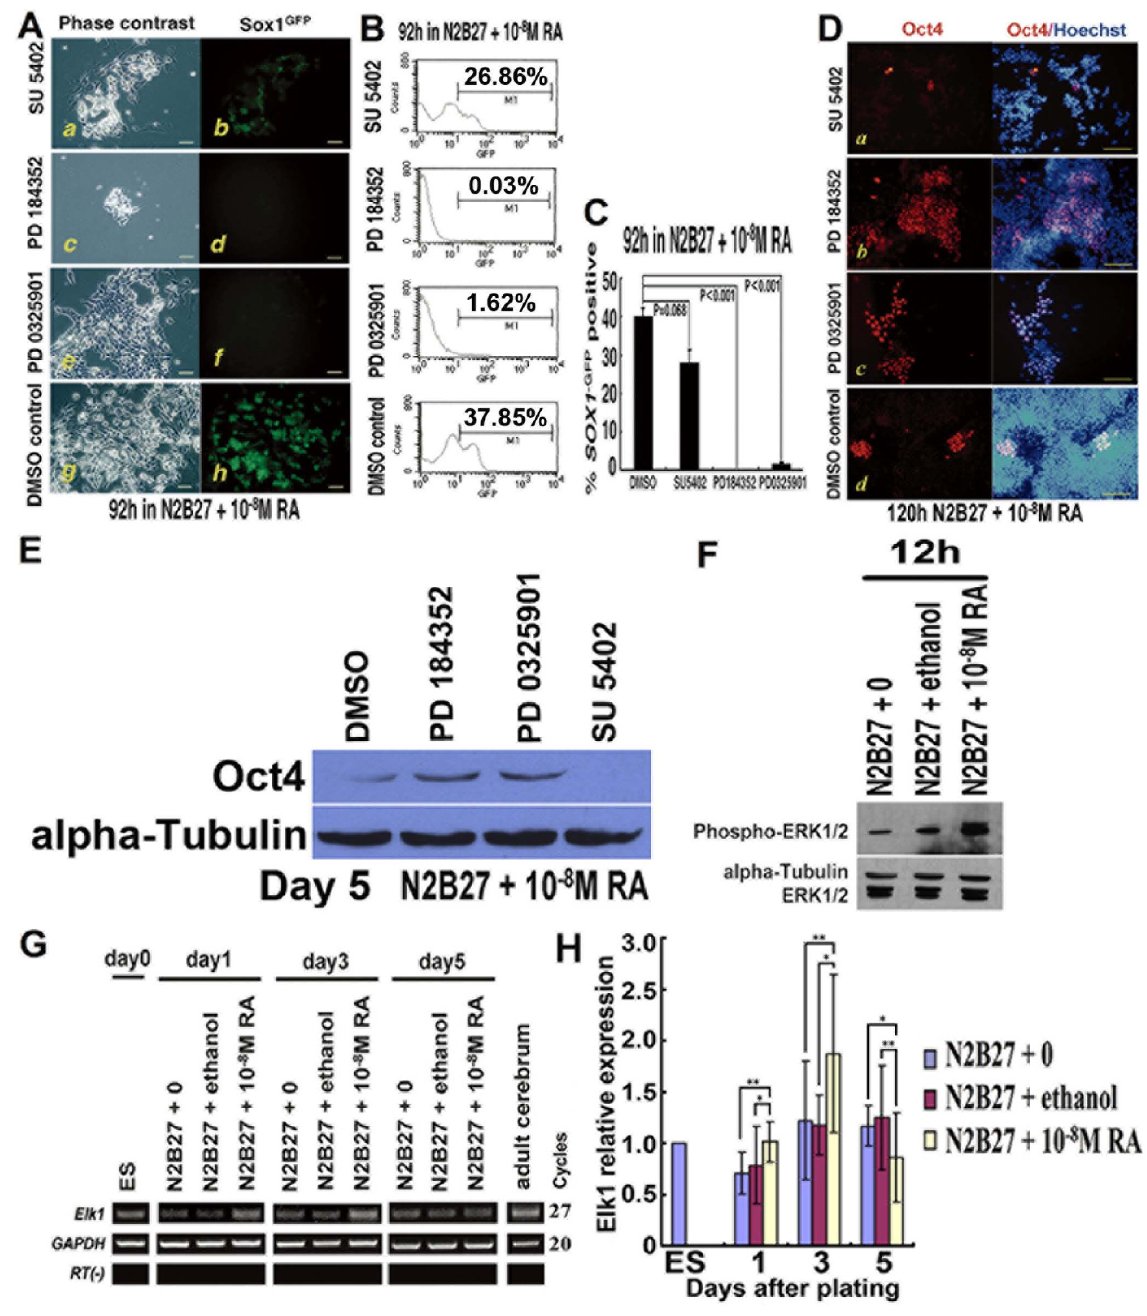
Figure 4 RA could not bypass the requirement for ERK signaling in neural specification . Monolayer differentiation of 46C ESCs in RA-treated cultures (N2B27 + 10 -8 M RA) exposed to FGF receptor tyrosine kinase inhibitor SU5402 (5 μ M), MEK1/2 inhibitors PD184352 (4 μ M) or PD0325901 (4 μ M), or to equivalent amounts of DMSO diluents. A , Cultures of monolayer dif- ferentiation, shown in phase contrast or stained for Sox1 GFP ; B , Typical FACS profile of Sox1 GFP expression; C , Percentage of Sox1 GFP + cells scored by FACS; D , Cultures of monolayer differentiation, shown in stained for Oct4 or combination of Oct4 and Hoechst; E , Western blot analysis of Oct4 at day 5 under monolayer cultures; F , Western blot analysis of phosphorylated ERK1/2 and ERK1/2 at 12 h under monolayer cultures; G , RT-PCR for Elk1 , one of the targets of ERK signaling; H , Q-PCR for Elk1 during monolayer differentiation. *, p < 0.05; **, p < 0.01. Scale bars: A, 40 μ m; D, 80 μ